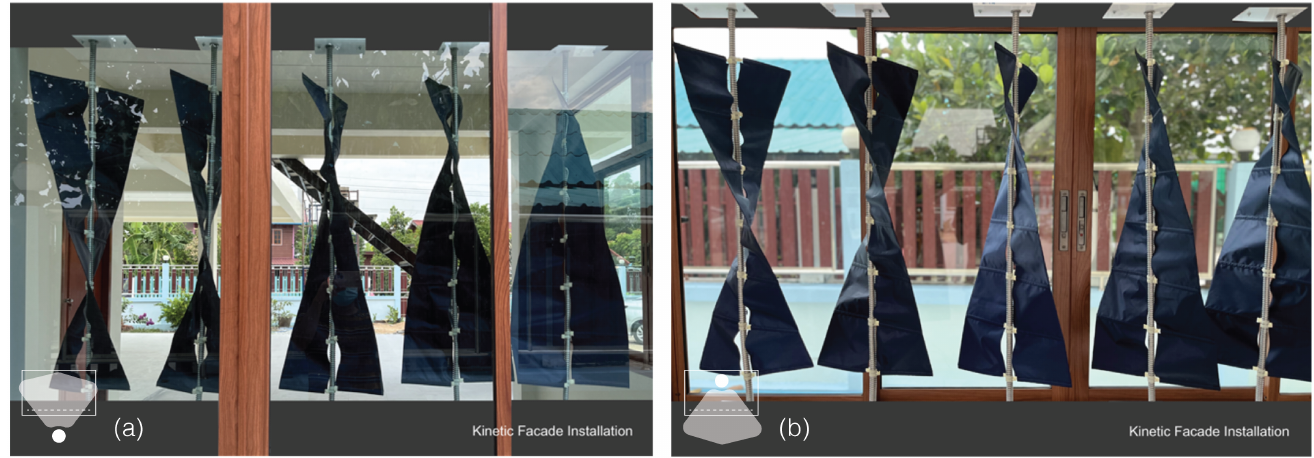
Figure 20. The kinetic façade (version 2: twisting movement) installation views from outside and inside. ( a ) The kinetic façade installation (view from outside); ( b ) The kinetic façade installation (view from